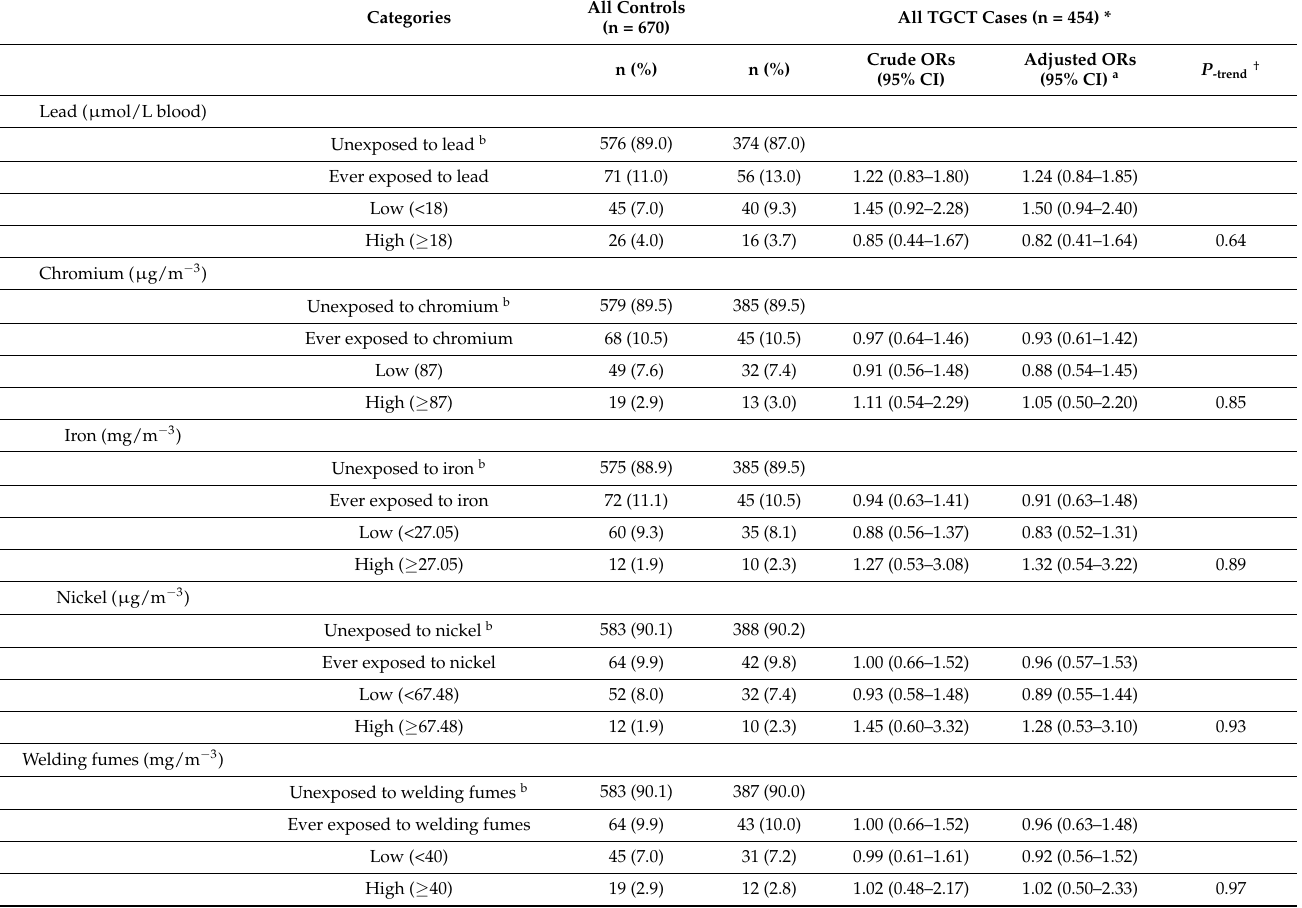
Table 2. Odds ratios (ORs) and 95% confidence intervals (95% CI) for TGCT associated with paternal occupational exposure to a low and high exposure index of specific agents, TESTIS study, 2015–2018, France (n =